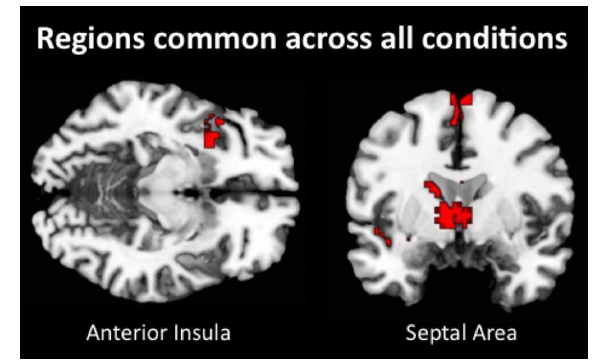
FIGURE 6 | Neural regions that were commonly activated during empathize, watch, and memorize (collapsed across emotions) relative to